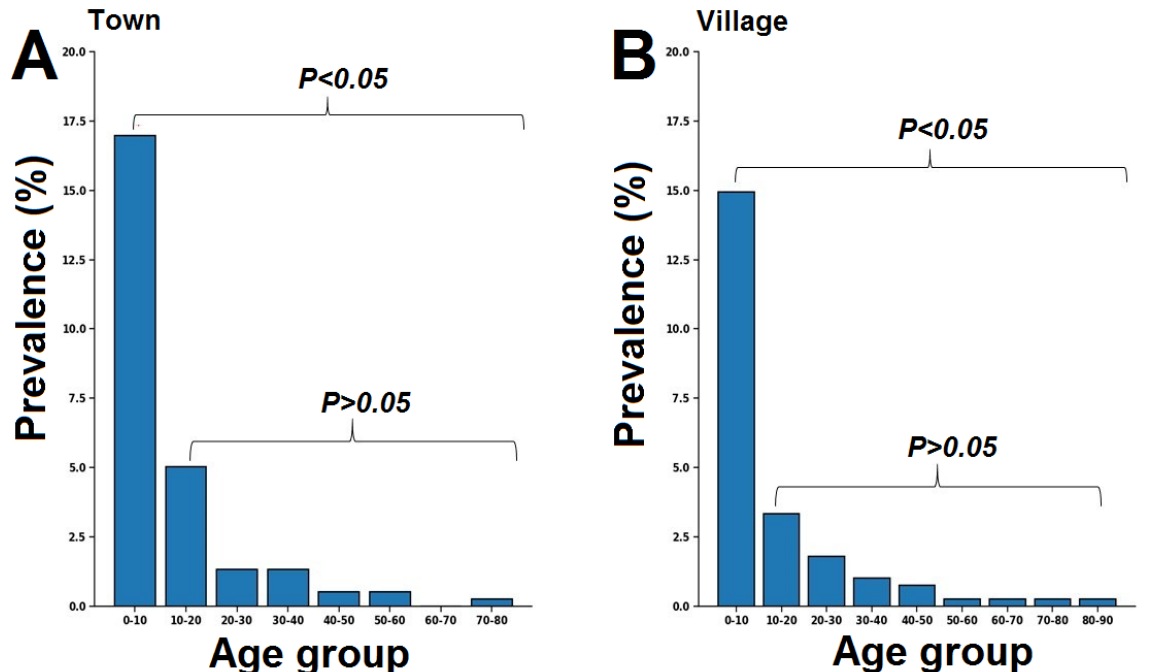
Figure 3. Malaria cases prevalent in the age group of patients in town (A) and village (B)